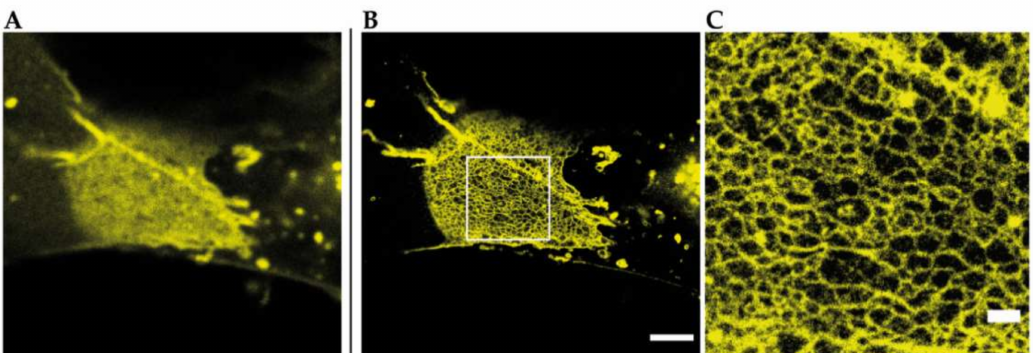
Figure 4. Reconstituted TJ networks formed by YFP-claudin-3 in Cos7 fibroblasts (unpublished data) imaged by using STED microscopy; ( A ) confocal overview image of a reconstituted TJ meshwork at the overlapping area of two transfected cells; ( B ) STED image of the same meshwork area from A. Scale bar: 2 µ m; ( C ) magnification of the marked area in B. Scale bar: 500